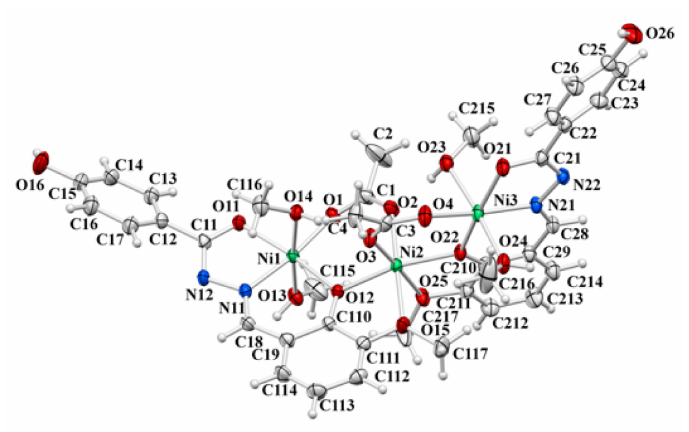
Figure 1. ORTEP view of molecular structure of 1 · 2MeOH · MeCN. The displacement ellipsoids are drawn at the 50% probability level at 150(2) K. The solvent molecules of crystallisation have been omitted for